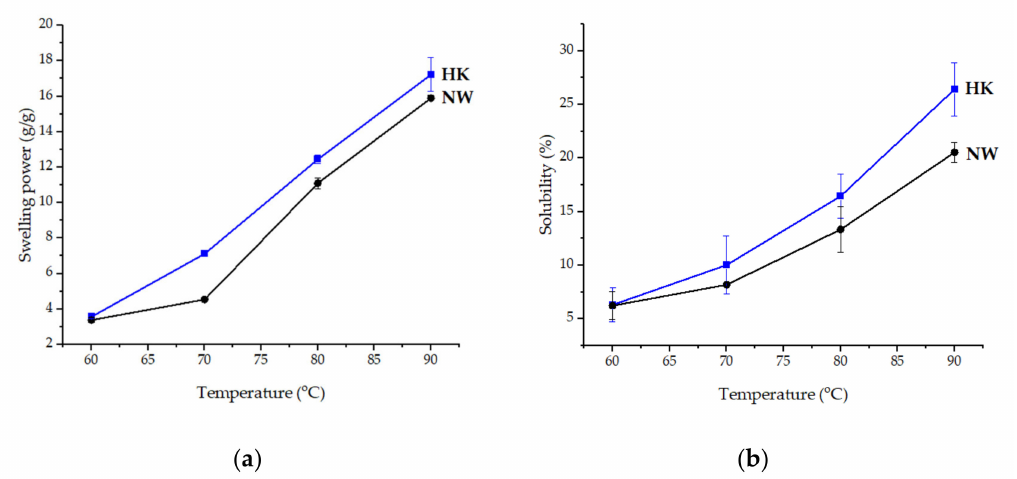
Figure 7. ( a ) swelling power of HK and NW banana starches ( b ) solubility of HK and NW banana